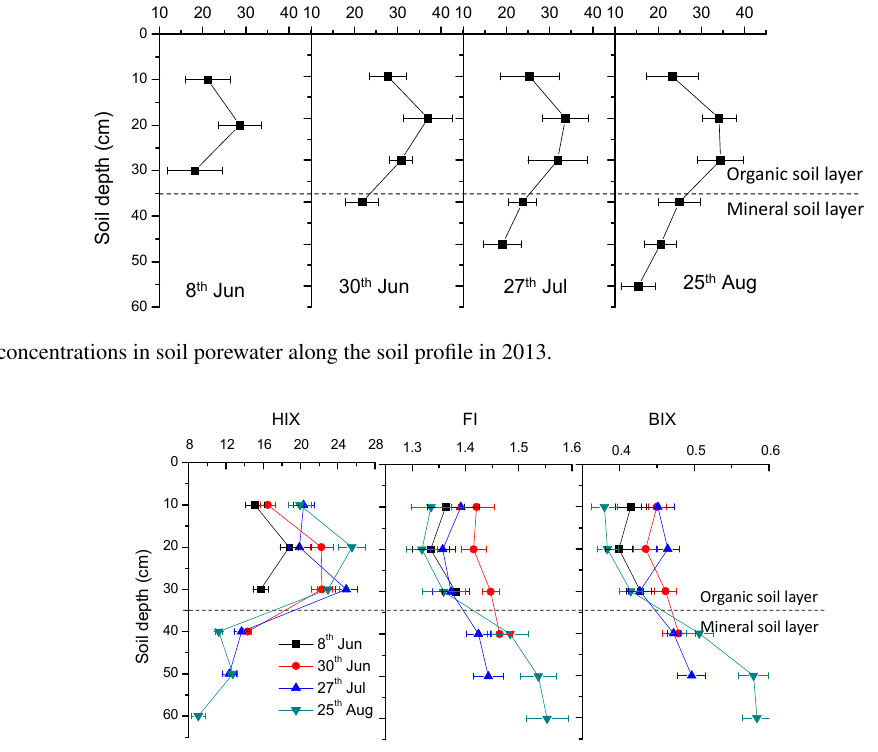
Figure 8: Vertical distribution of the three spectral indices for soil pore water along the soil profile in 2013.